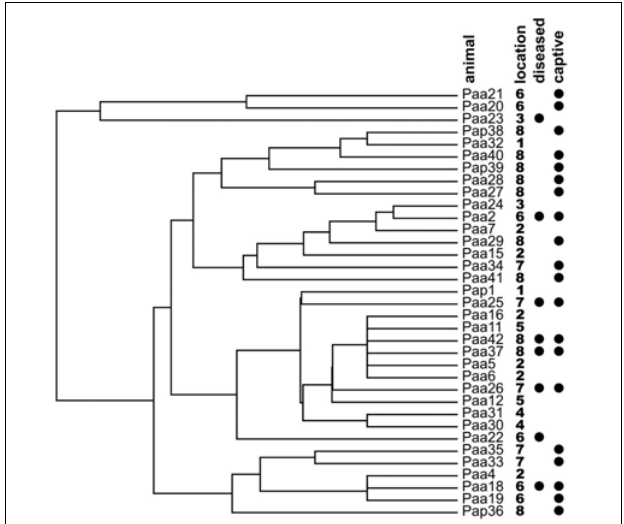
FIGURE 7 | Hierarchical clustering analysis of the olm specimens based on the presence/absence of cultivable fungal genera on the skin of the sampled animals. Locations of specimen samplings are given next to the names of specimen (1: Vivarium 1; 2: crna jama; 3: Vivarium 3; 4: Jelševnik; 5: Planinska jama; 6: Vivarium 2; 7: Vir pri Sticni; and 8: Kompoljska jama). Symptomatic diseased animals and animals held in captivity prior to sampling are marked with black